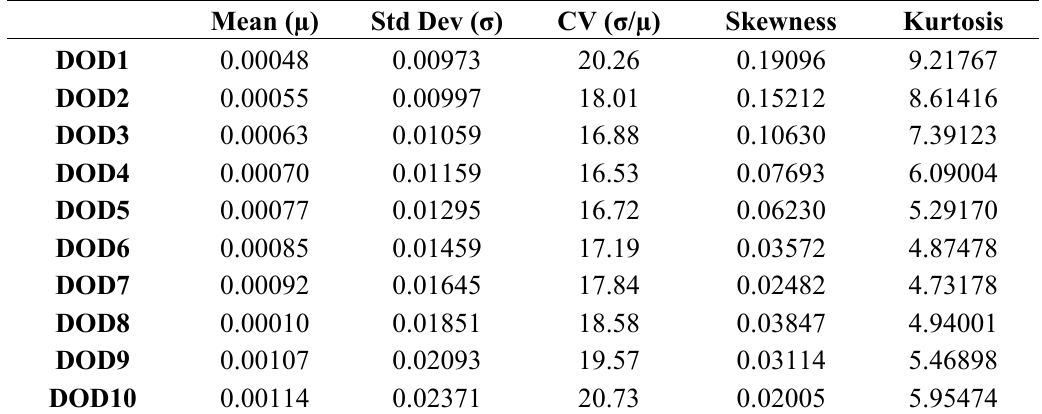
Table 2. Summary statistics of the domestic MV efficient diversified